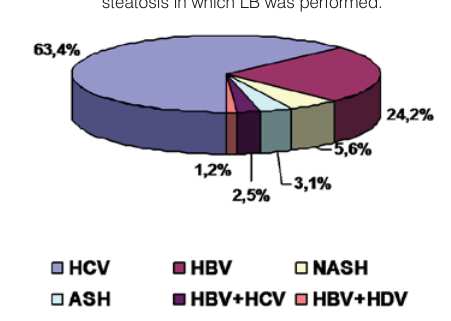
Figure 2. Concordance between US and pathological diagnosis of steatosis.